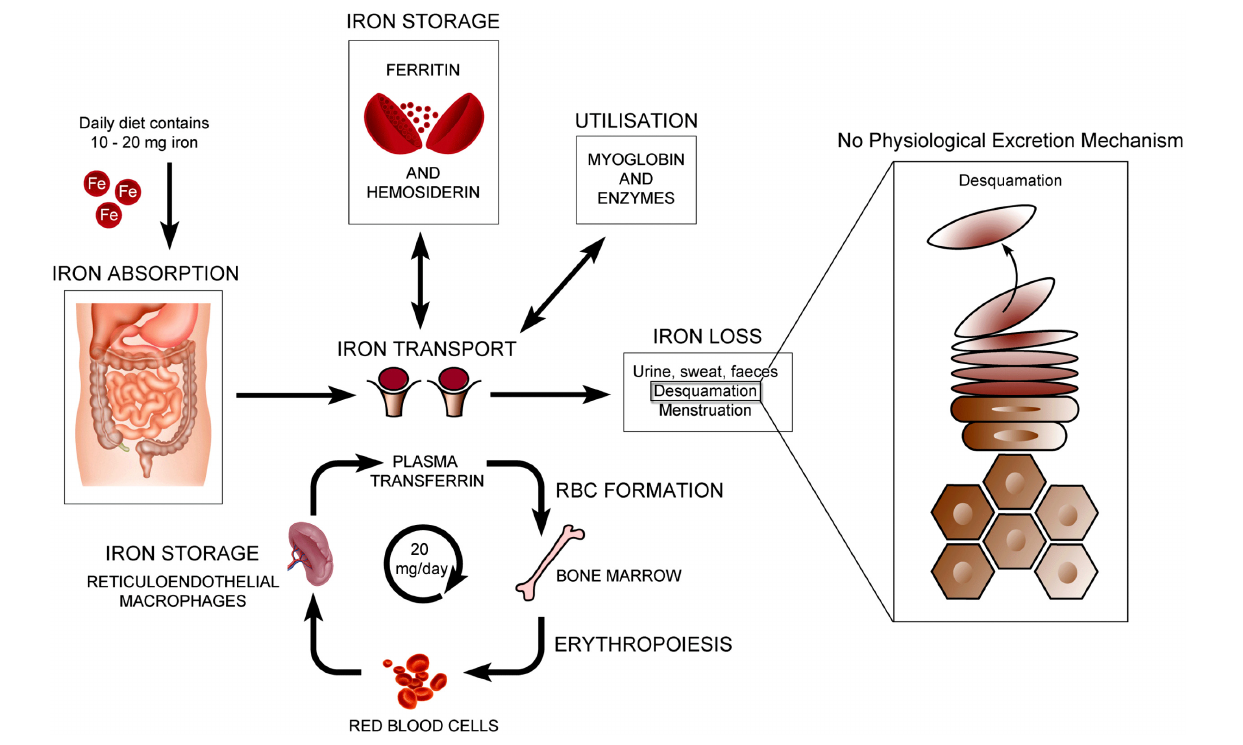
FIGURE 2 | Normal physiology of iron homeostasis. Figure adapted to show key iron physiology including iron loss by desquamation (see Milstone etal., 2012).